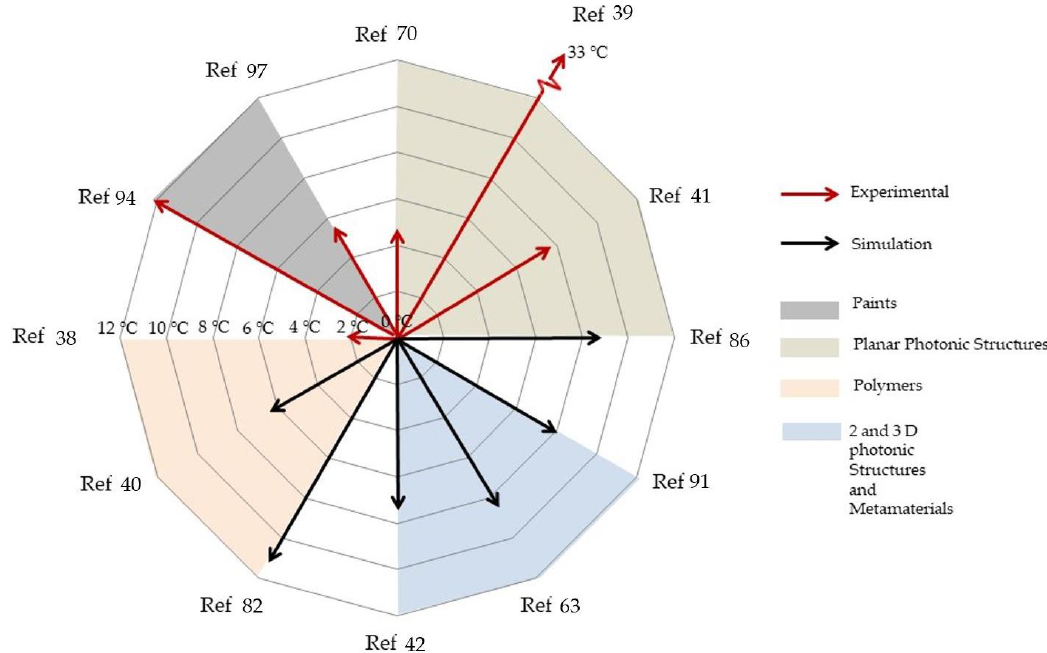
Figure 4. Measured and simulated temperature drop below the ambient temperature for selected radiative structures.